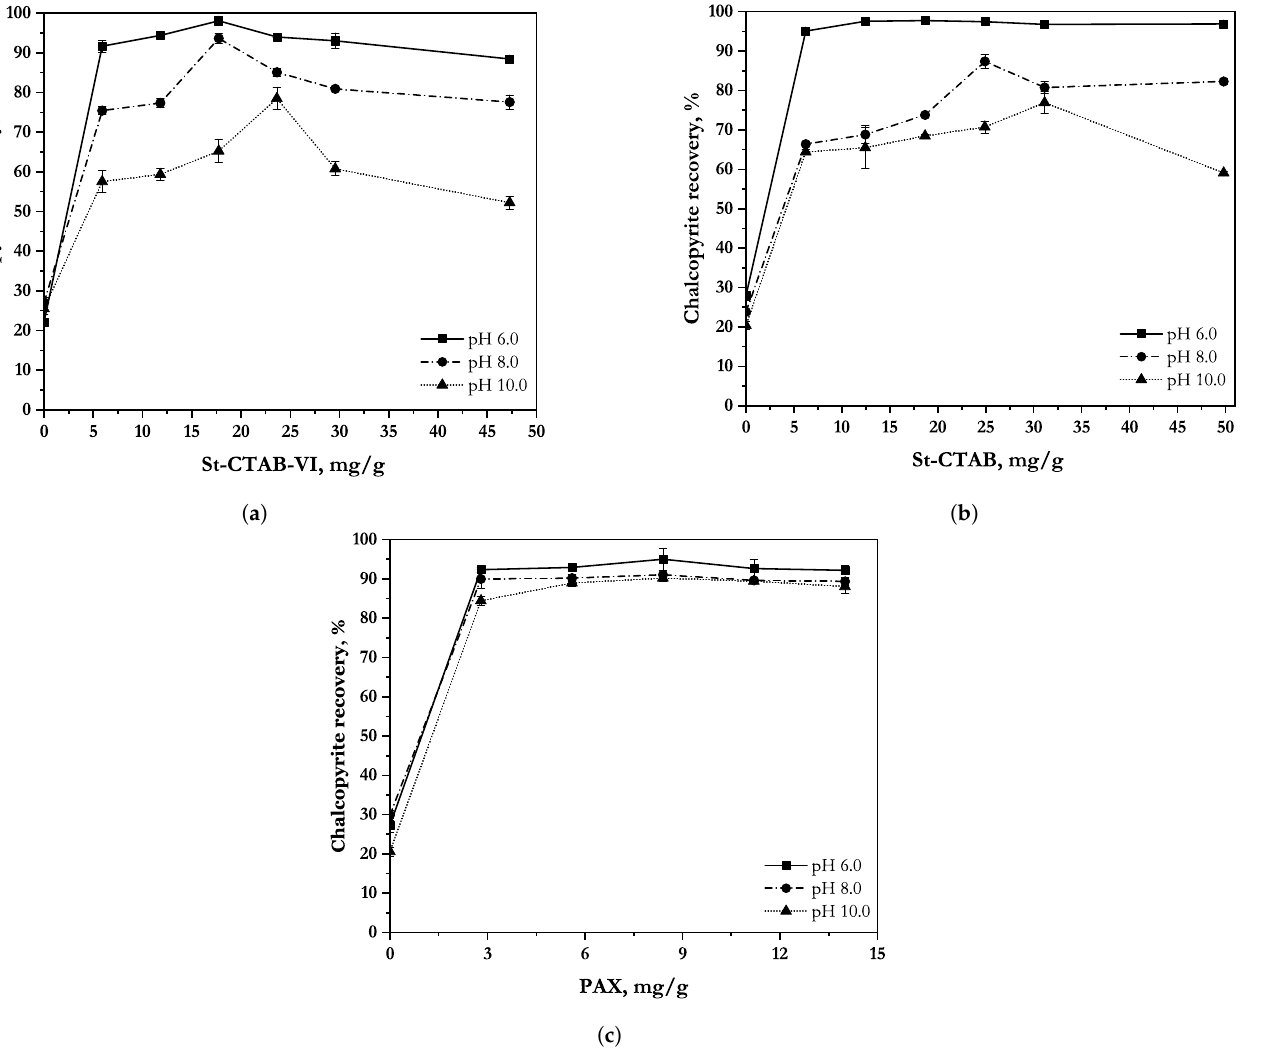
Figure 5. Chalcopyrite recovery as a function of St-CTAB-VI ( a ), St-CTAB ( b ) and PAX ( c ) concentra- tion at different pHs, using 10 ppm of Aerofroth 70 and 5mM NaCl